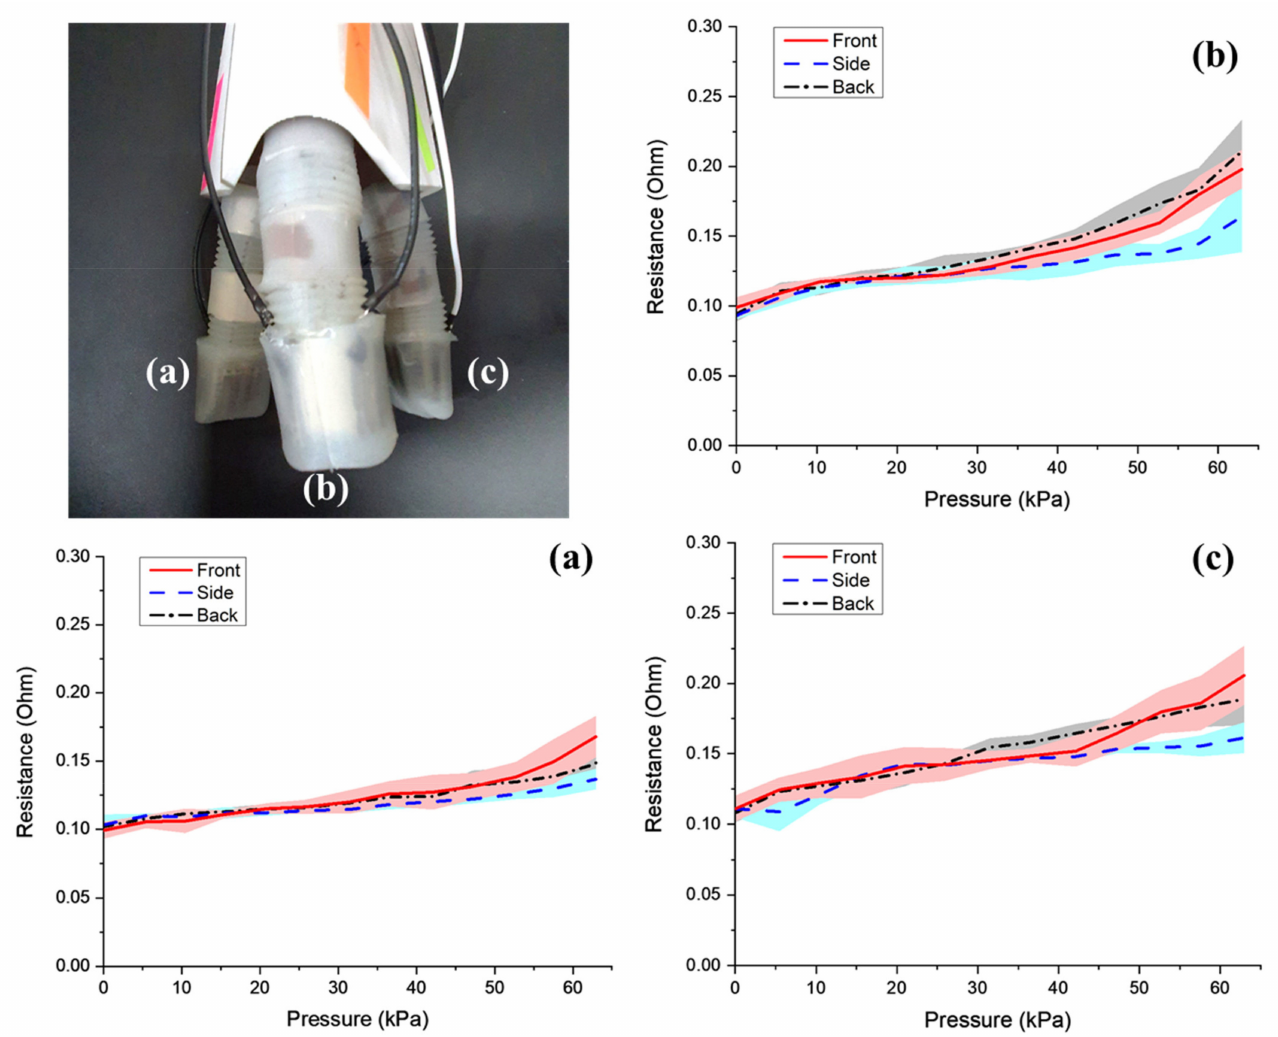
Figure 24. Position-based sensor response for fingers labeled ( a – c ) in the top left